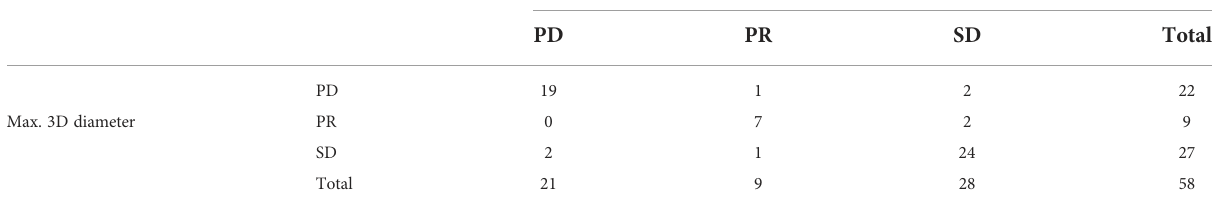
TABLE 6 Comparisons of response assessment between RECIST 1.1 and max. 3D diameter.